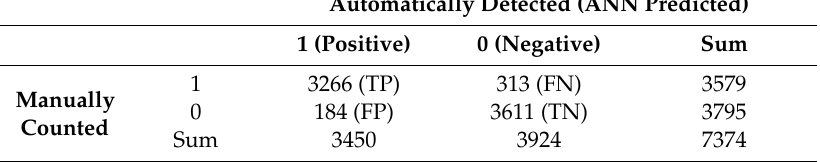
Table 2. Contingency table showing the performance summary of the sensor system tested at 5 field sites in Tordas and É rd in 2018. ANN = artificial neural network, TP = true positive, TN = true negative, FP = false positive, FN = false